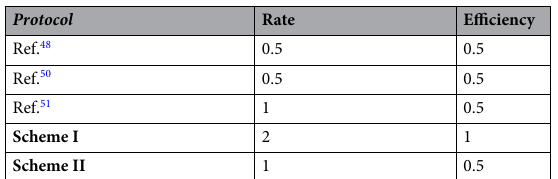
Table 3. Comparison between proposed and existing 48,50,51 relativistic QKD protocols in terms of rate